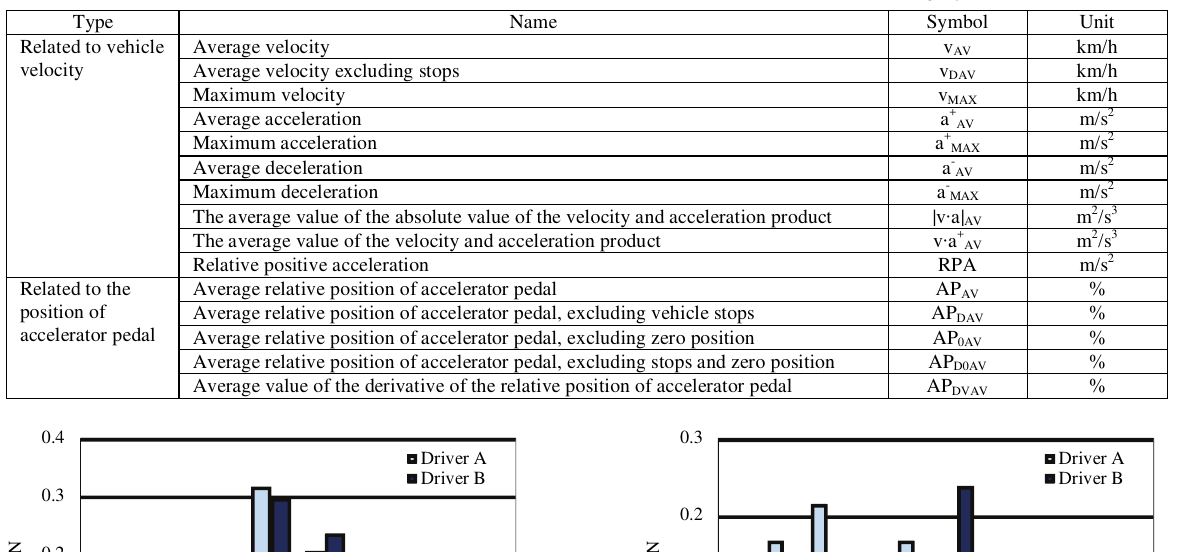
Table 3. Zero-dimensional characteristics considered as criteria for the assessment of driving style